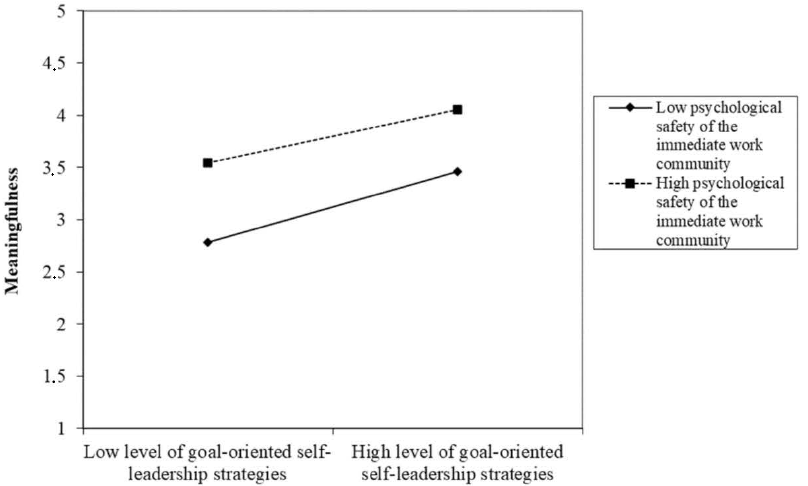
Figure 2. A significant interaction effect between goal-oriented self-leadership strategies and psycho- logical safety of the immediate work community.